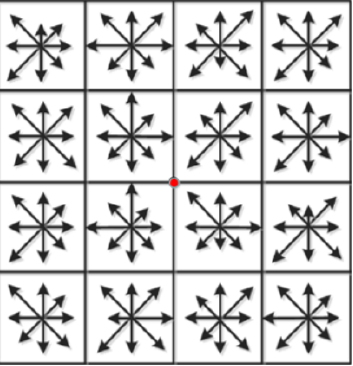
Figure 2. Depiction of the 128-dimensional feature